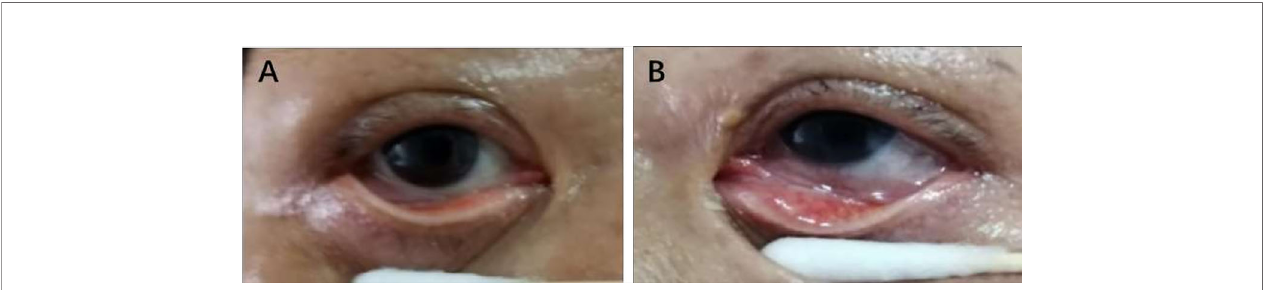
FIGURE 1 | Slit-lamp photographs of the patient ’ s eyes. Conjunctival congestion and conjunctival follicles in the left eye (B) and the right eye was normal (A) .